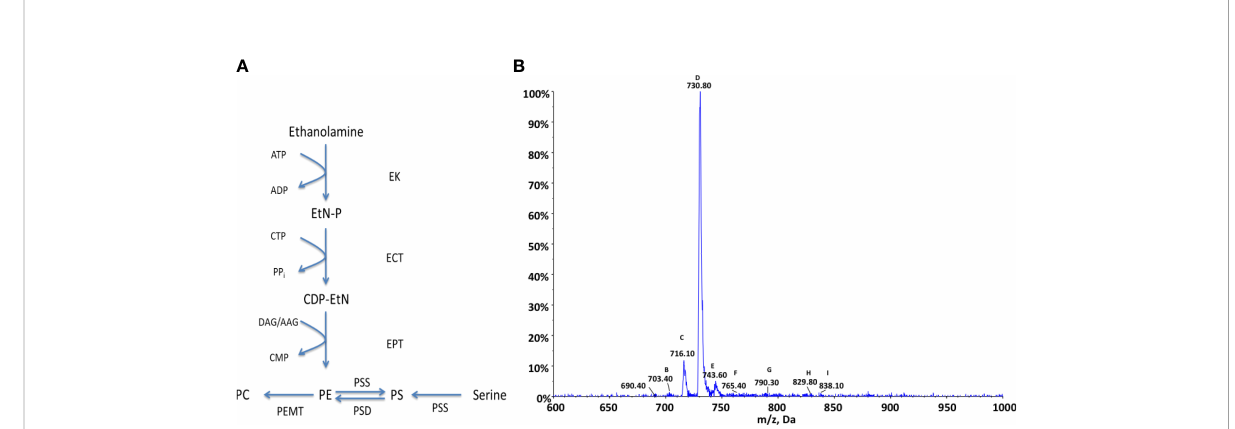
FIGURE 4 Ethanolamine metabolism in Crithidia (A) An overview of PE metabolism in most eukaryotes. Key - ECT, Ethanolamine-phosphate cytidylyltransferase; EK, ethanolamine kinase; EPT, Ethanolamine phosphotransferase; PEMT, Phosphatidylethanolamine N-methyltransferase; PSD, Phosphatidylserine decarboxylase; PSS, Phosphtidylserine synthase; AAG, alkyl-acylglycerol; ADP, adenosinediphosphate; ATP, adenosine- triphosphate; CDP-EtN, cytidine diphosphate-ethanolamine; CMP, cytidine monophosphate; CTP, cytidine-triphosphate; DAG, diacylglycerol; EtN-P, ethanolamine phosphate. (B) ESI-MS-MS negative parent ion scan of PE lipids from C. fasiculata lipid extract, scanning for m/z 196. Peaks are plotted as their relative intensity (%) to that of the largest peak in the spectrum and in terms of their mass to charge (m/z) ratio. (Species identi fi cation in Table